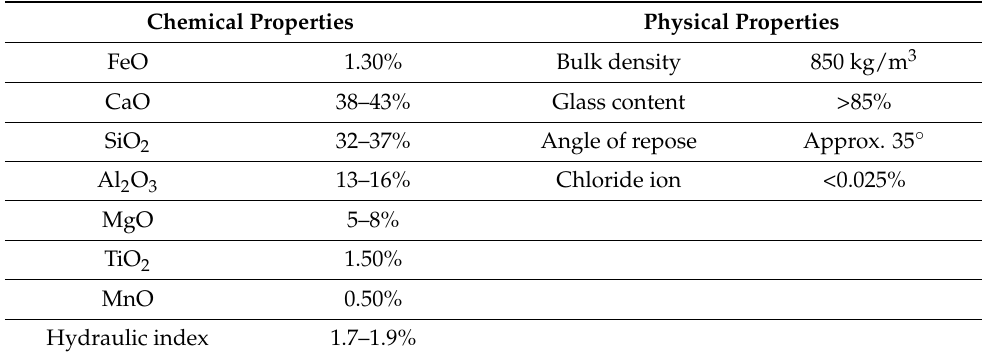
Table 2. Chemical and physical properties of GGBFS.